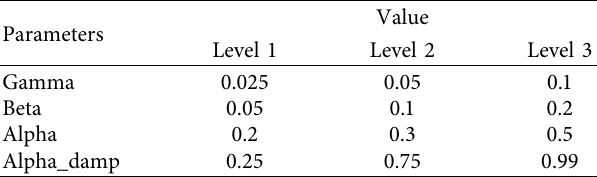
Table 7: Parameters and levels for the firefly algorithm.